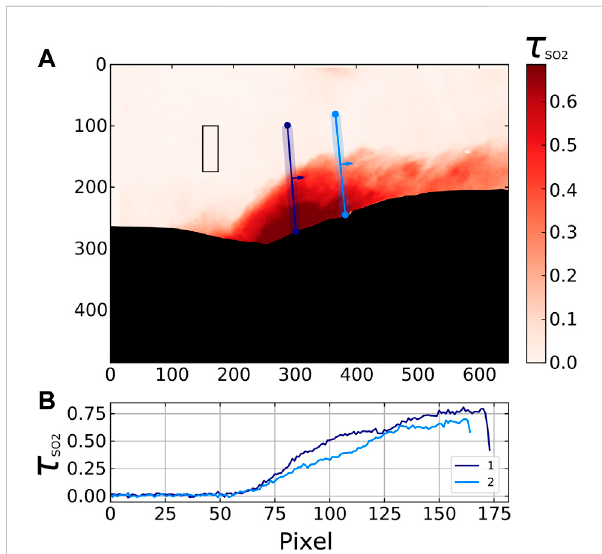
FIGURE 5 (A) Optical depth image of Lascar volcano from an acquisition at 14:00:35 UTC (10:00:35 CLT) on 25th May 2022. The black rectangle indicates the region of clear sky where the intensity I 0 was estimated. (B) Opticaldepthvaluesacrossintegrationlinesshownin (A) .The dark blue line was used for emission rate retrievals whilst the light blue was the secondary line used for cross-correlation plume speed estimation.